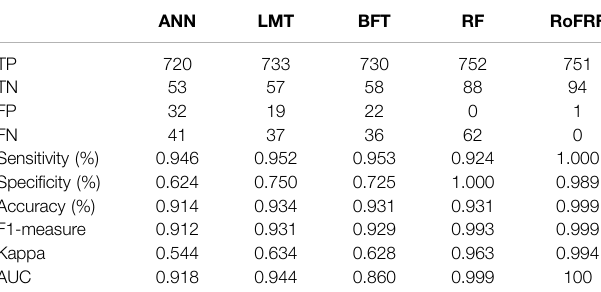
TABLE 3 | Model results using the training dataset.